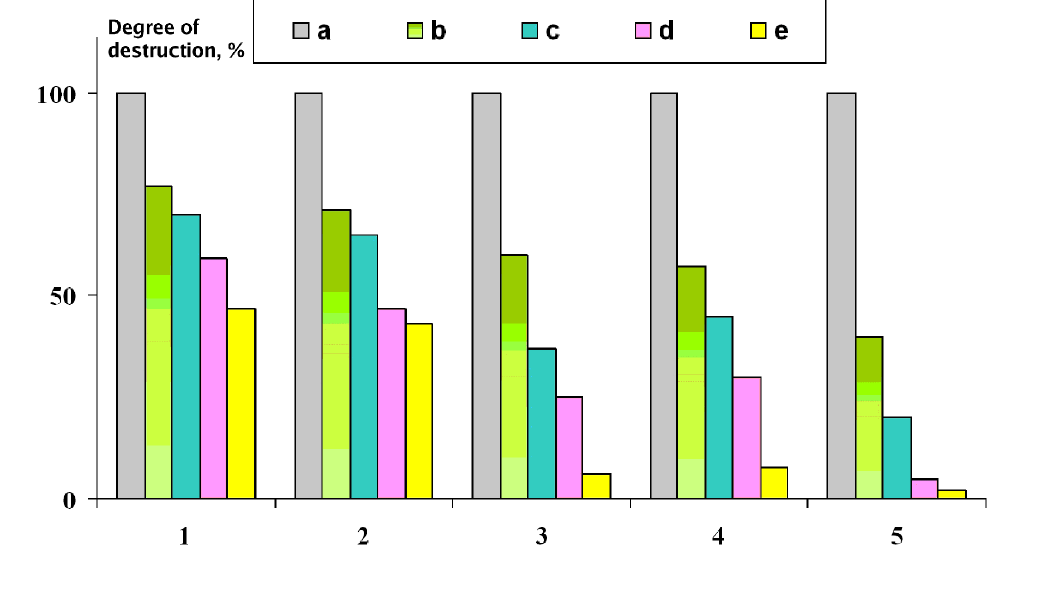
Fig. 2 In®uence of the nature of bactericidal sorbents on destruction of fungus lauer containing Bacillus Pyocyaneous during